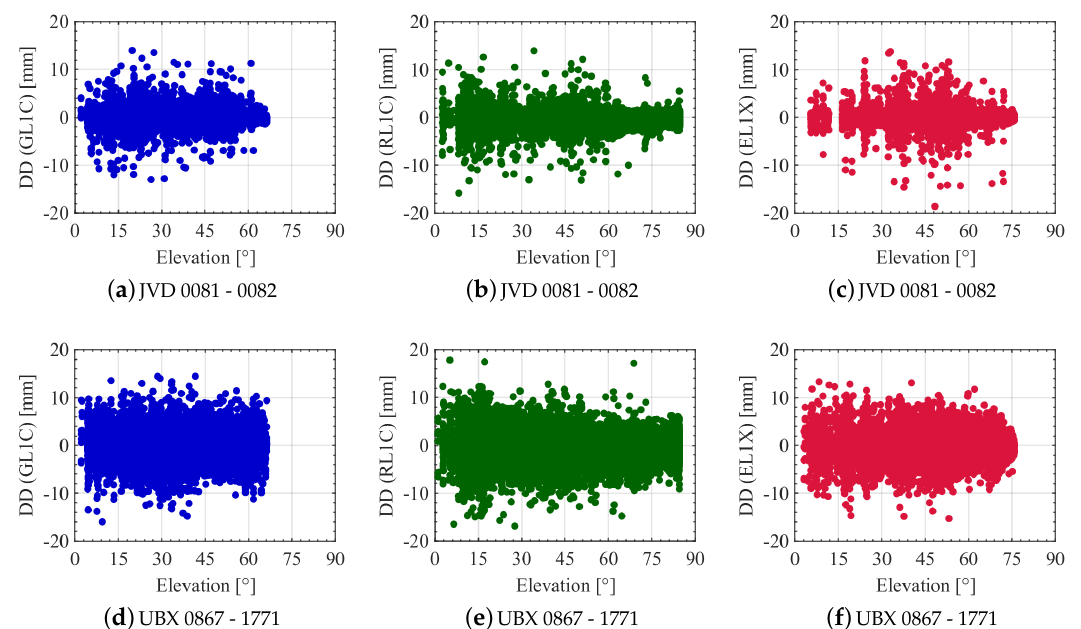
Figure 10. DDs of L1 carrier phase observations from all satellites for different receiver combinations with respect to the elevation angle of the non-reference satellites. GPS, GLONASS and Galileo noise levels are shown in blue, green and red colours, respectively.